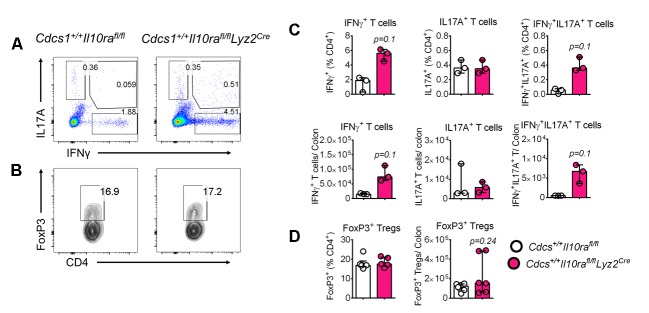
Immunophenotyping of 3–4 week old Cdcs1+/+Il10rafl/fl Lyz2Cre and littermate Cdcs1+/+Il10rafl/fl control mice.Representative FACS plots (A, B), and graphical comparison of frequencies and total numbers of intracellular cytokine positive CD4+ Th cells (C), and FoxP3+ Tregs (D) in the colons of 3–4 week old mice described in Figure 6. *p<0.05, **p<0.01, Mann-Whitney U test. Data shows Median with IQR. Each data point indicates individual mouse. Data in (C) is representative of 2 litters, whereas pooled data from two litters resulting in 5–6 mice in each group is shown in (D).